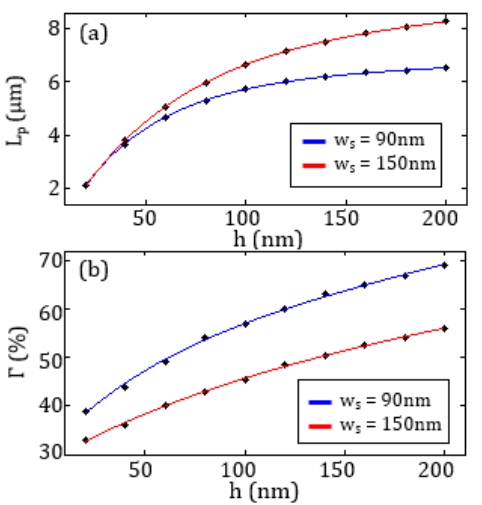
Figure 4. Behaviour of ( a ) L p and ( b ) Г as a function of h with w s = 90 nm (blue curve) and w s = 150 nm (red curve).